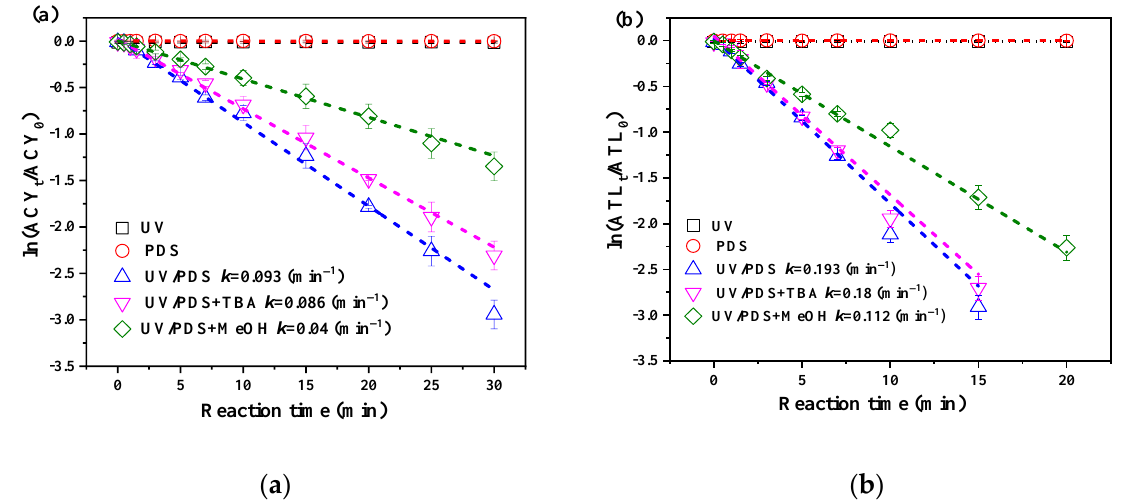
Figure 1. ACY ( a ) and ATL ( b ) degradation by UV, PDS, UV/PDS, UV/PDS + TBA, and UV/PDS + MeOH processes. Conditions: [ACY] 0 = 0.022 mM, [ACY] 0 = 0.019 mM, [PDS] 0 = 0.6 mM, [TBA] 0 = [MeOH] 0 = 10 mM, pH = 6.0.